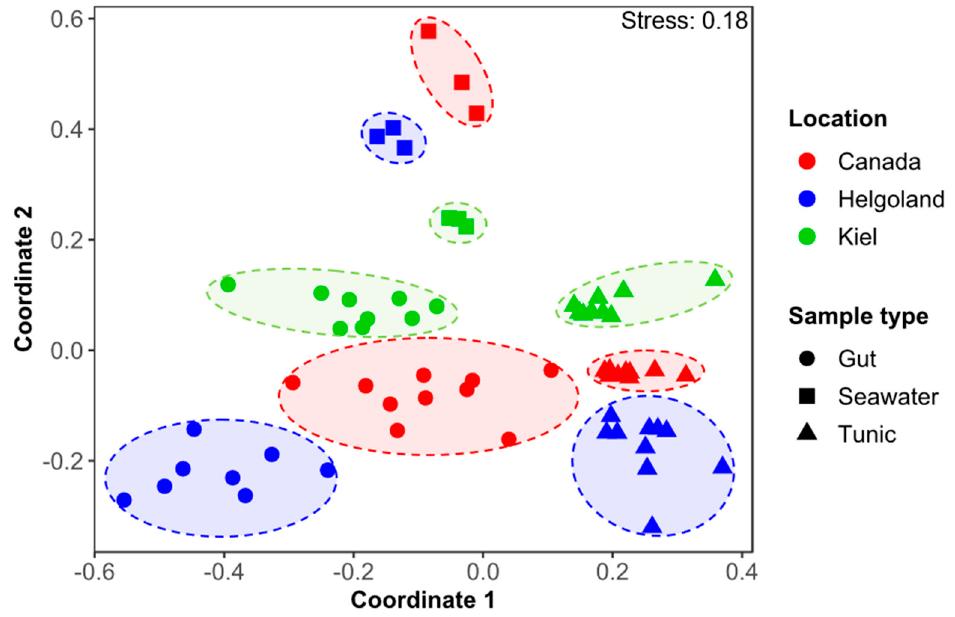
Figure 2. Across sample type and geographic origin comparison of the C. intestinalis -associated microbiome. The 2D nMDS plot was calculated using the full set of detected OTUs (5211) and is based on a Bray-Curtis similarity matrix.